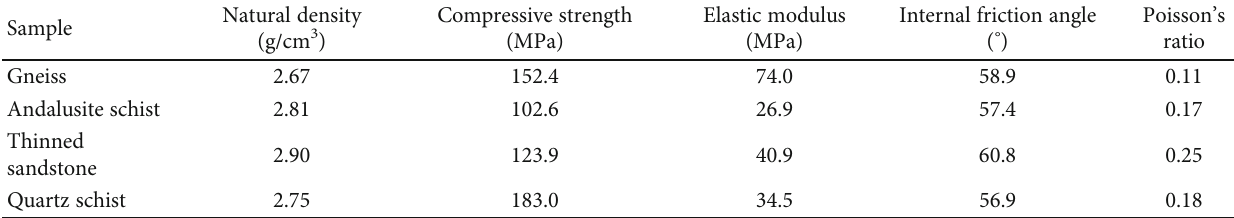
Table 1: Average spacing of the structural planes.